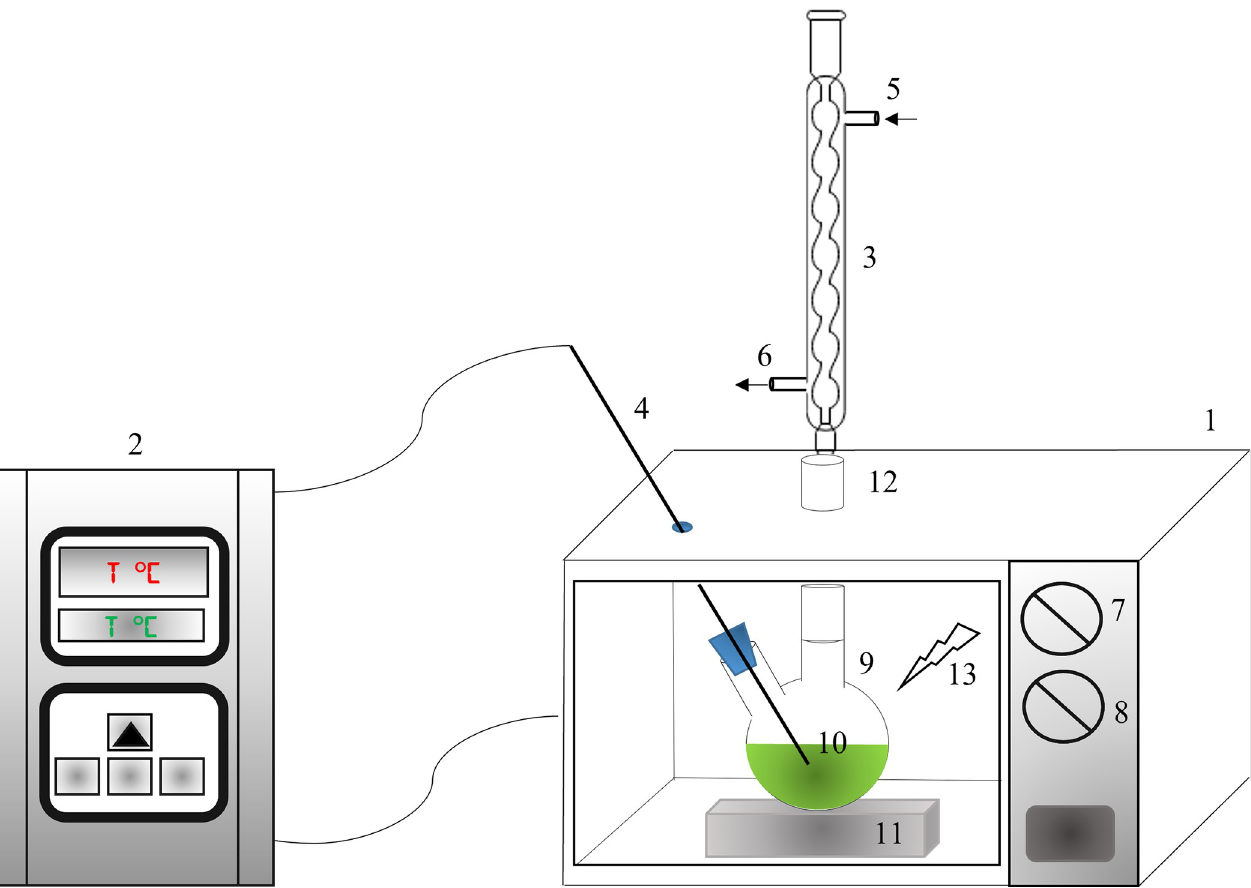
Fig 1. Schema of experimental setup for MAILE: (1) Modified microwave oven, (2) Signal transmitted controller with on/off relay switch, (3) Reflux condenser, (4) Thermocouple, (5) Cold water in, (6) Hot water out, (7) Power regulator, (8) Timer, (9) Round bottom flask, (10) Ionic liquid solution and algae powder, (11) Ceramic pad, (12) Connecting tube, and (13) Irradiation microwave